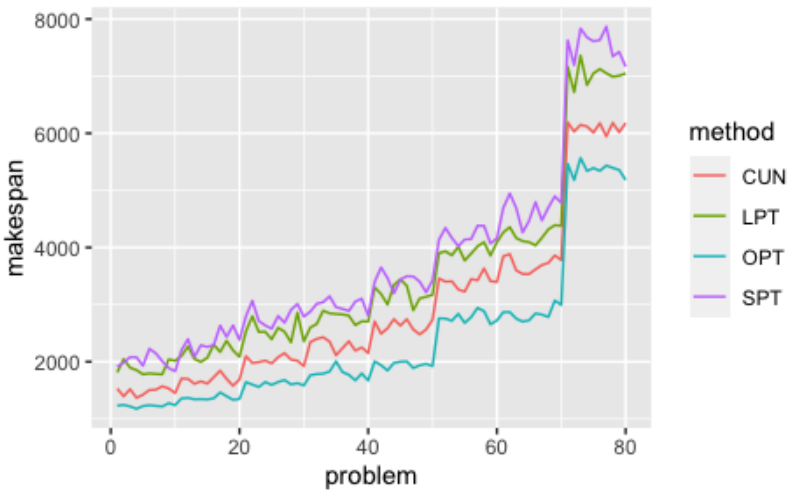
Figure 6. Makespan for LPT , SPT , CUN and the optimal value for each